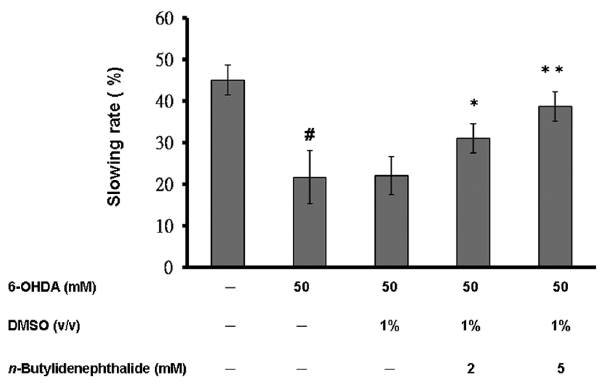
Figure 6. n -Butylidenephthalide improves food-sensing behav- ior in 6-OHDA-treated N2 C. elegans . The locomotory rate (frequency of bending) of 6-OHDA-untreated animals, 6-OHDA-treated animals, or n -butylidenephthalide/6-OHDA-treated animals with or without bacteria lawns was assayed. Shown are the slowing rates calculated as the percentage decrease of the locomotory rate in the bacteria lawn as compared with that in no bacteria lawn. The data represent the mean 6 SD (n=10). A hash ( # ) indicates significant differences between 6-OHDA-treated and untreated animals ( p , 0.001); an asterisk (*) indicates significant differences between the 6-OHDA- treated control samples and the n -butylidenephthalide/6-OHDA-treated samples (* p , 0.05, ** p , 0.01).